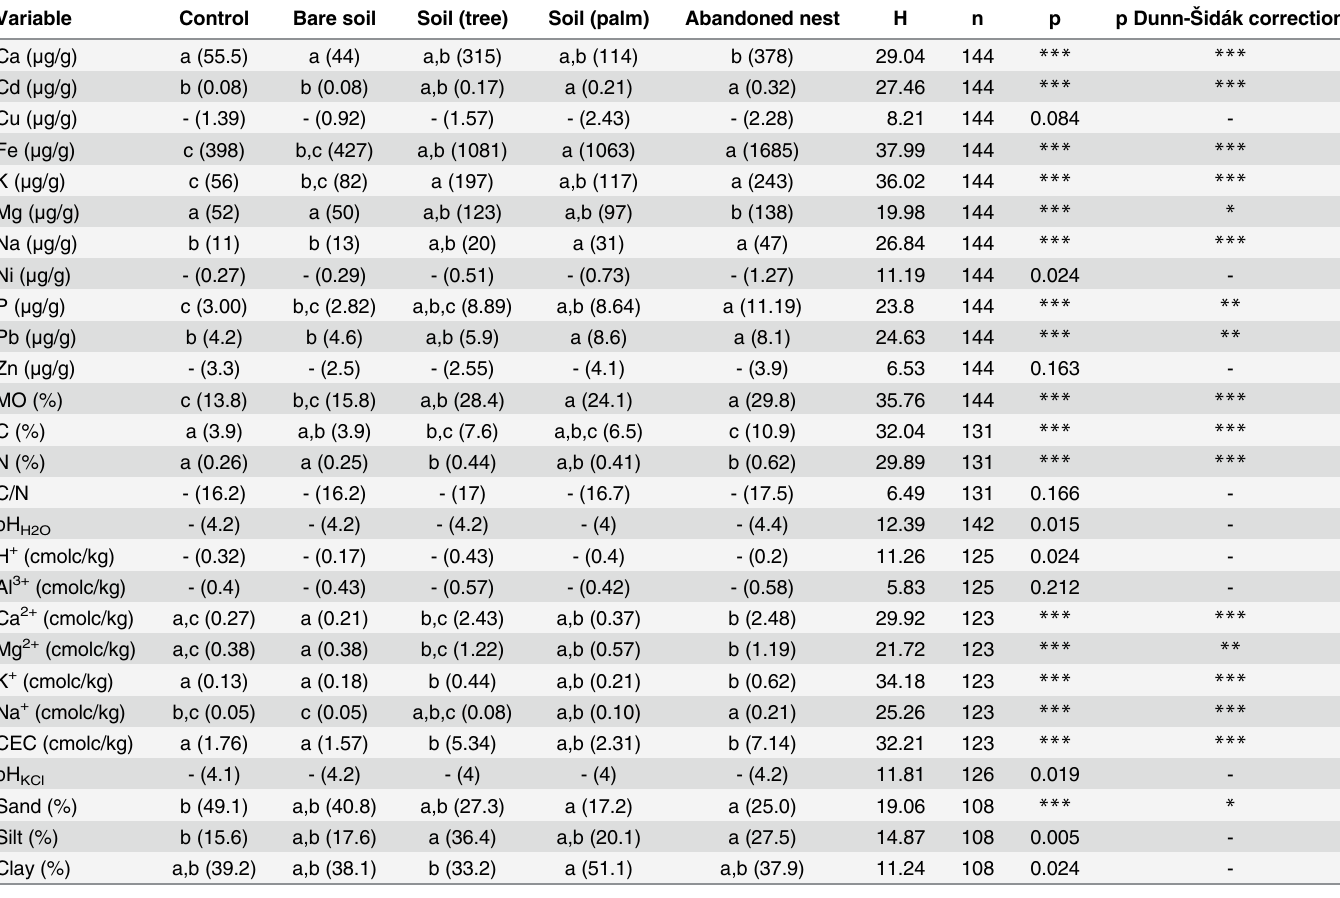
Table 1. Properties of soils associated with soil-feeding termites in four putative niche categories, with a non-parametric (Kruskal-Wallis) analysis of